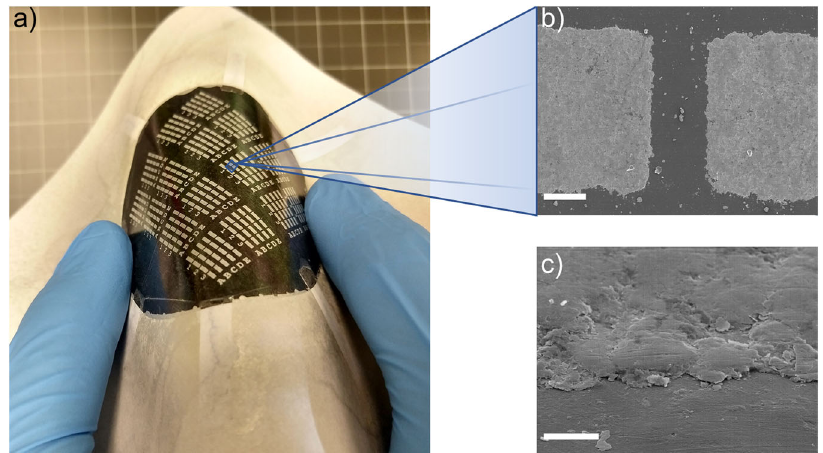
Fig. 2 Optical (left, a ) and scanning electron (right b , c ) microscopy images of aerosol spray lithography contact patterns. The scale bar in b corresponds to 200 μ m; the scale bar in c corresponds to 10 μ m. The device has a channel length of 200 μ m. The contacts are de fi ned by a positive toner mask and a coat of silver conductive spray. This device was printed on a piece of standard printer